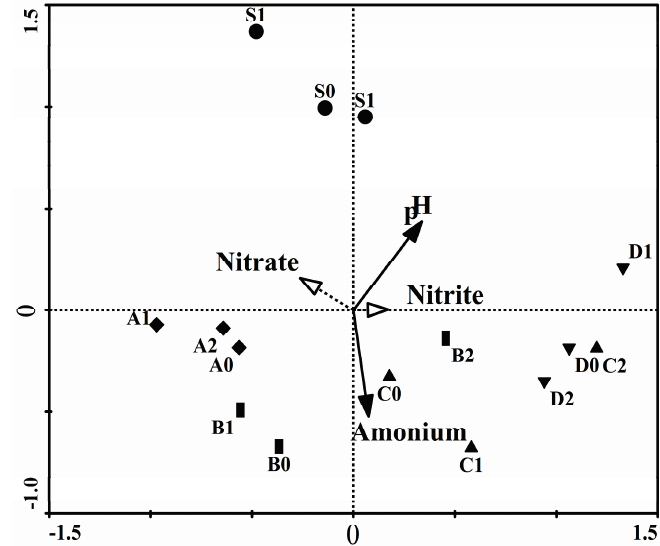
Figure 4. DGGE band data redundancy analysis for fungal communities. Significant composting parameters are indicated by solid lines with filled arrows, while supplementary parameters are shown using gray dotted lines with unfilled arrows. Samples with the same symbol were collected on the same